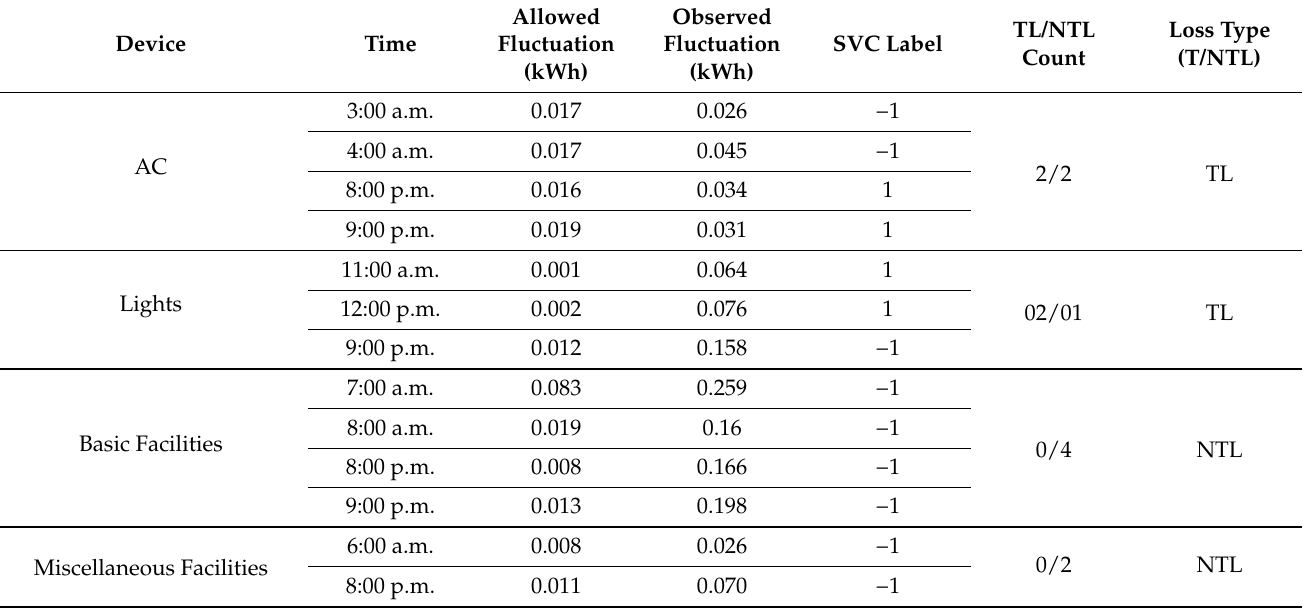
Table 5. SVC model based Loss Classification